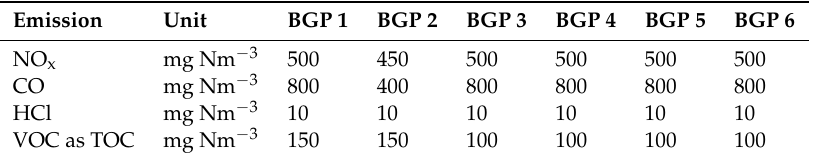
Table 5. Emission limits of the selected plants.